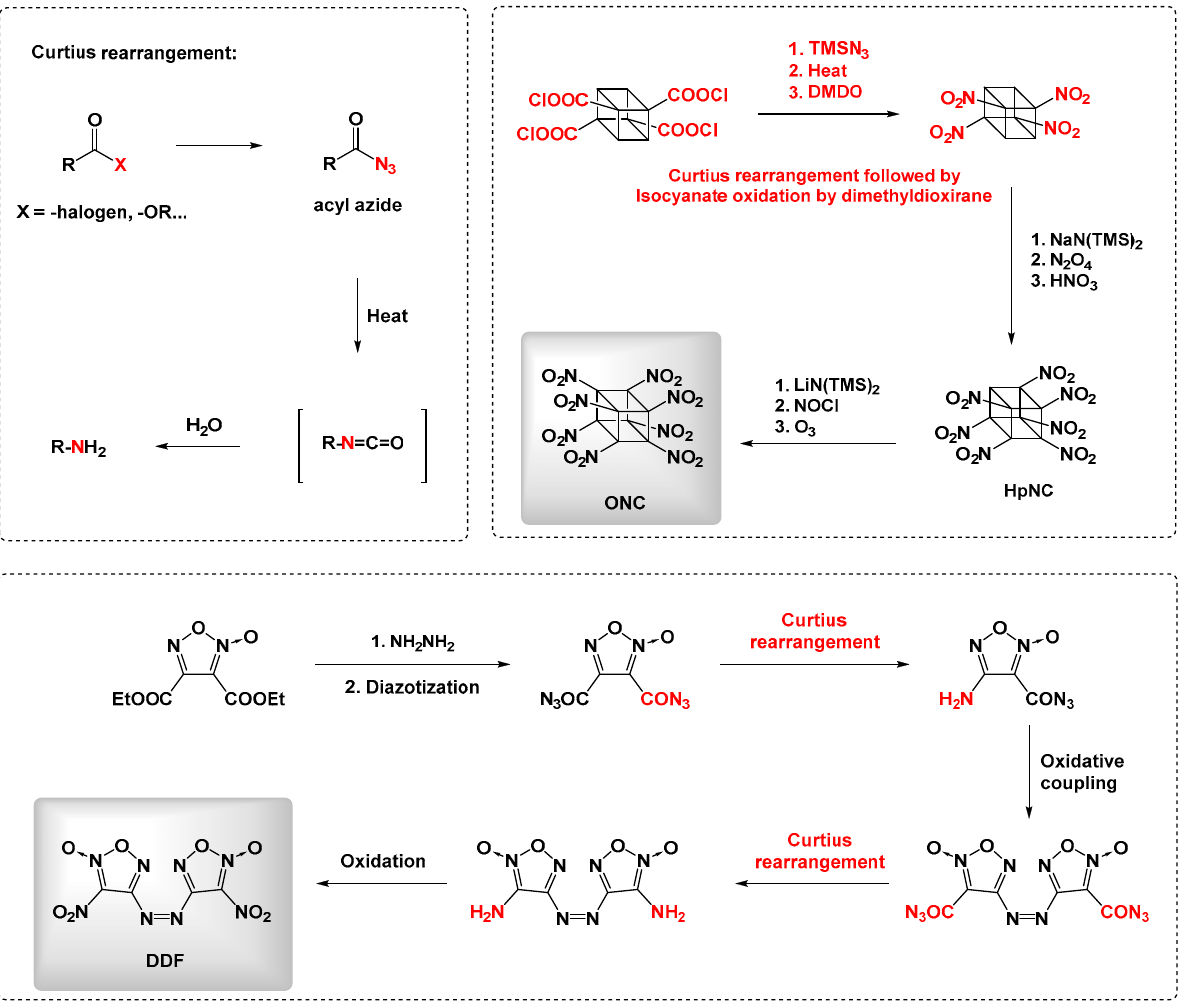
Figure 1. Curtius rearrangement in the synthesis of energetic materials.